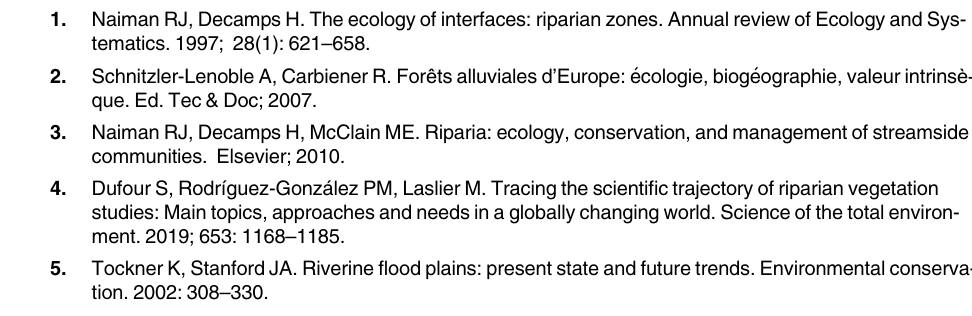
S1 Table. Raw data as basis for spatial analyzes. The percentages of land use (%) are available for all six sites over